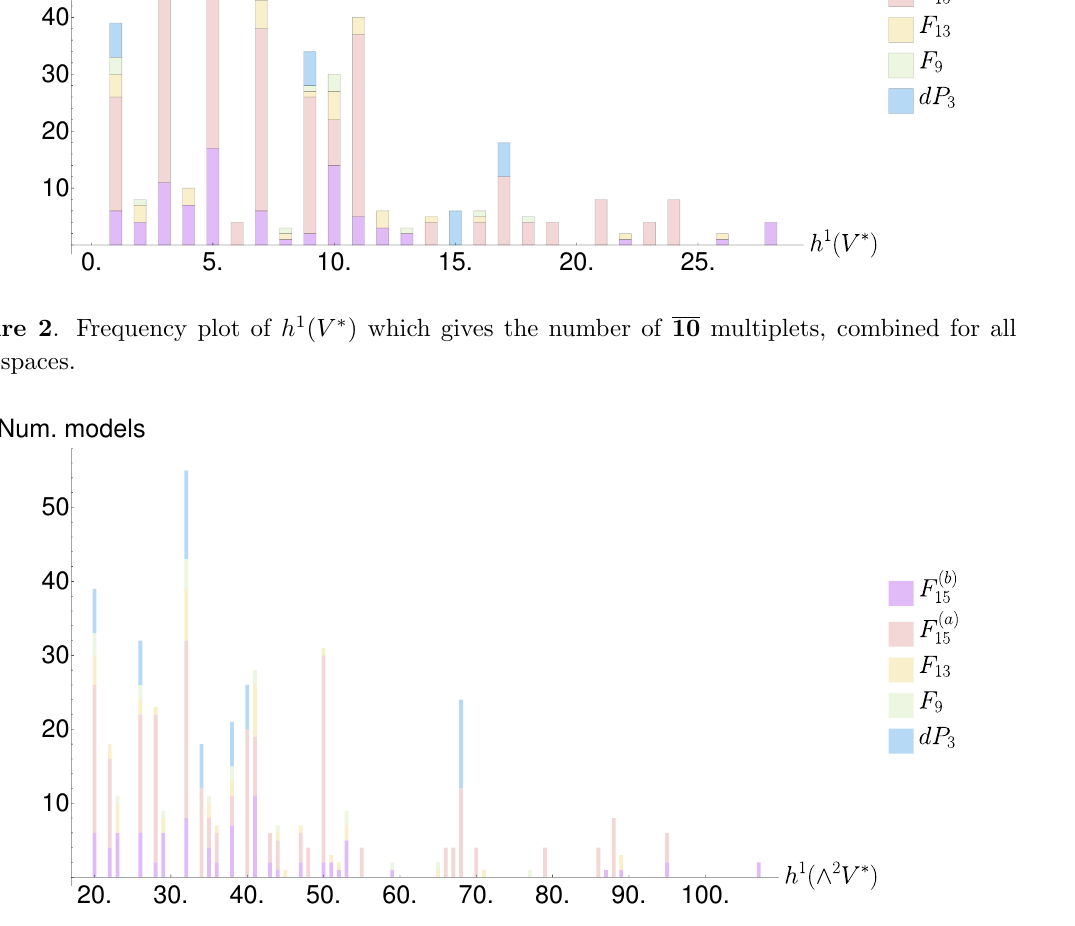
Figure 3 . Frequency plot of h 1 ( ^ 2 V (cid:3) ) which gives the number of 5 multiplets, combined all base space